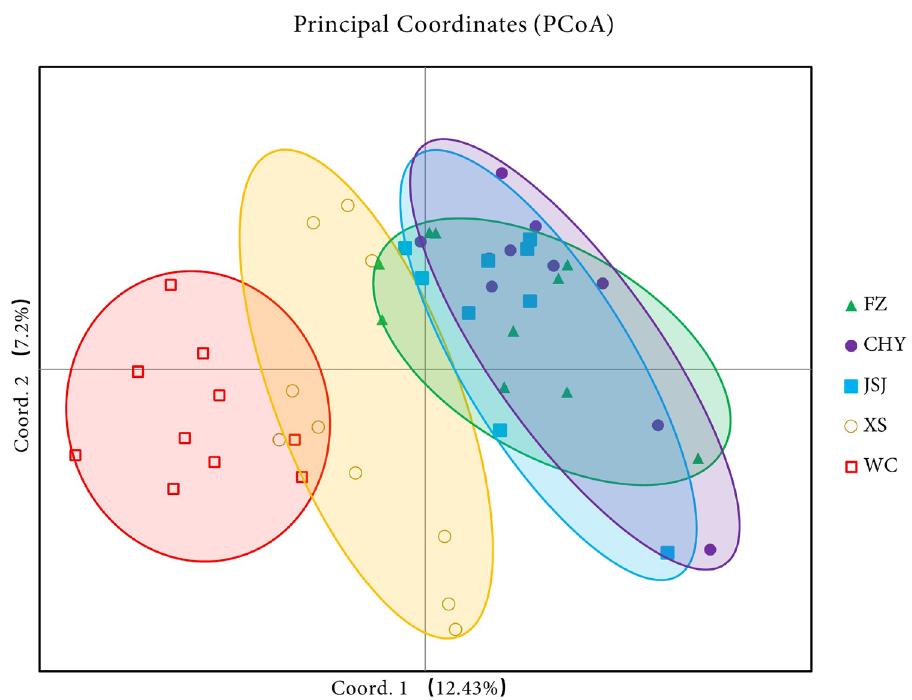
Figure 1. Principal coordinate analysis (PCoA) based on the genetic distance matrix of the total subepiloci matrix for individuals from different